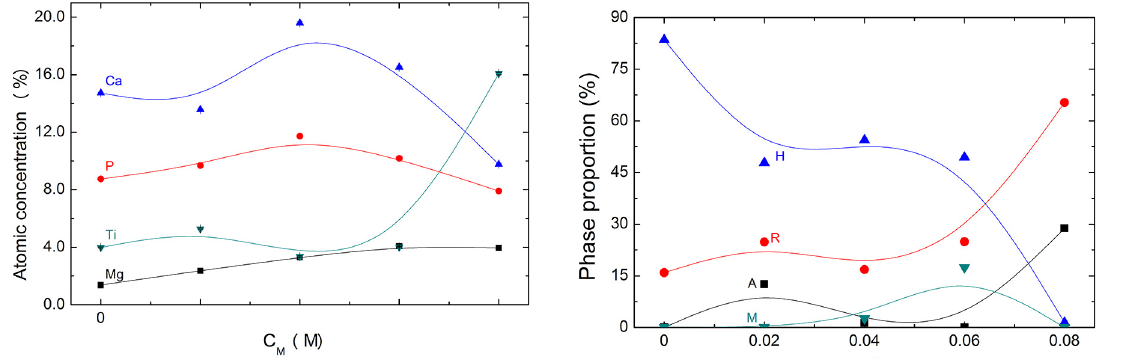
Figure 8. In addition, the same amount of P was bound as magnesium phosphide (Mg